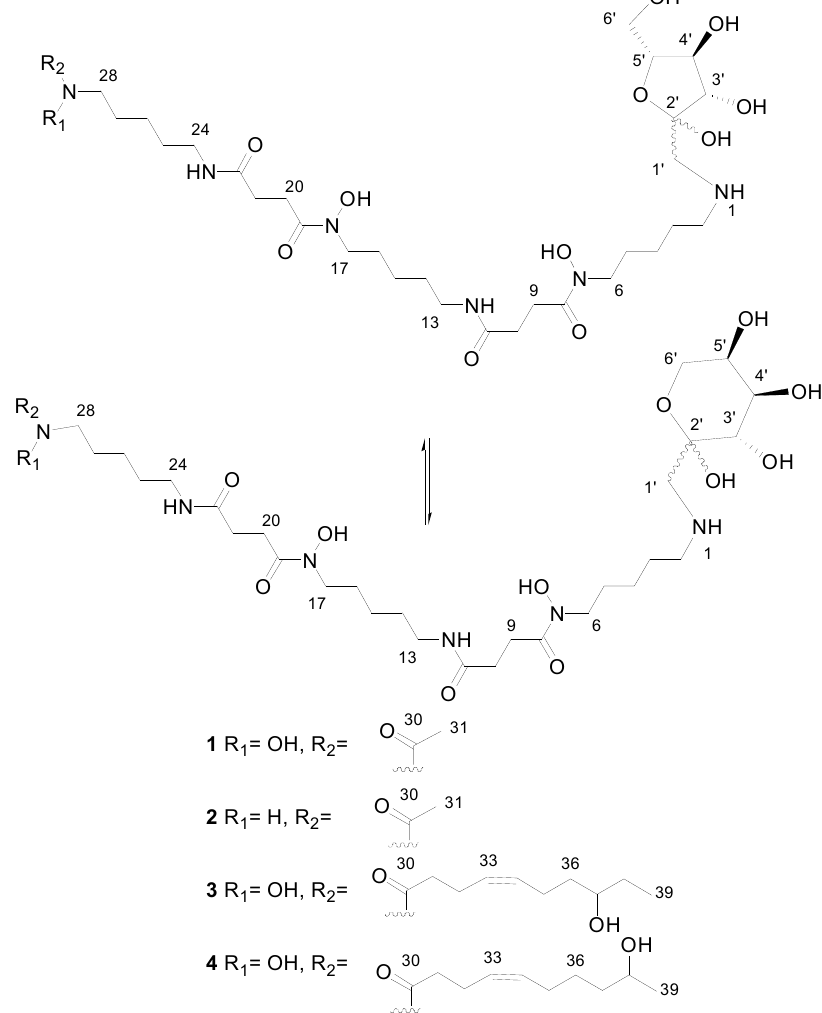
Figure 3. Chemical structures of deferoxamine glycoconjugates produced by genetically-manipulated S. albus PVA94-07.